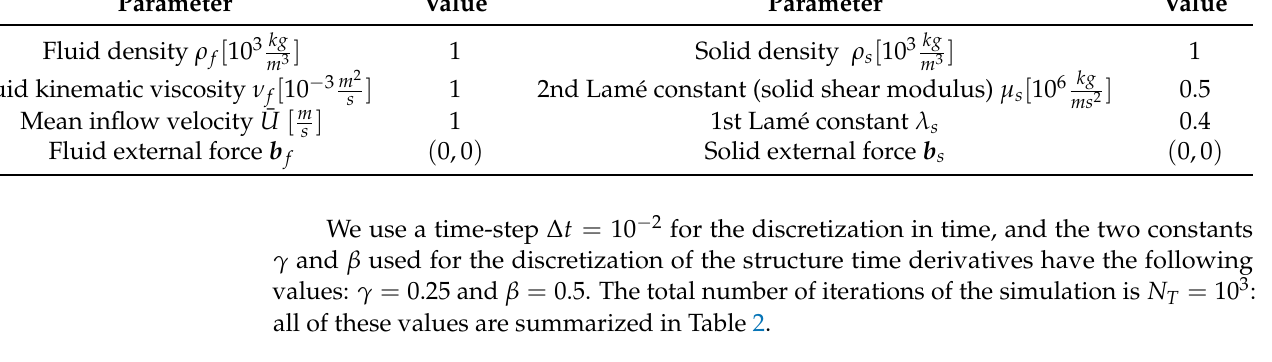
Table 2. Values of the parameters in the time discretization and in the spatial